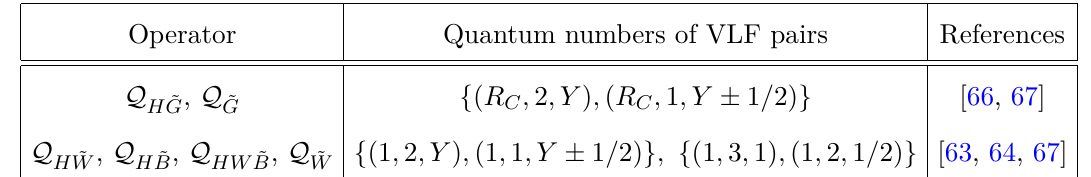
Table 3. Heavy field representations that have been found to yield CP-violating SMEFT operators after being integrated out along with the works reporting these